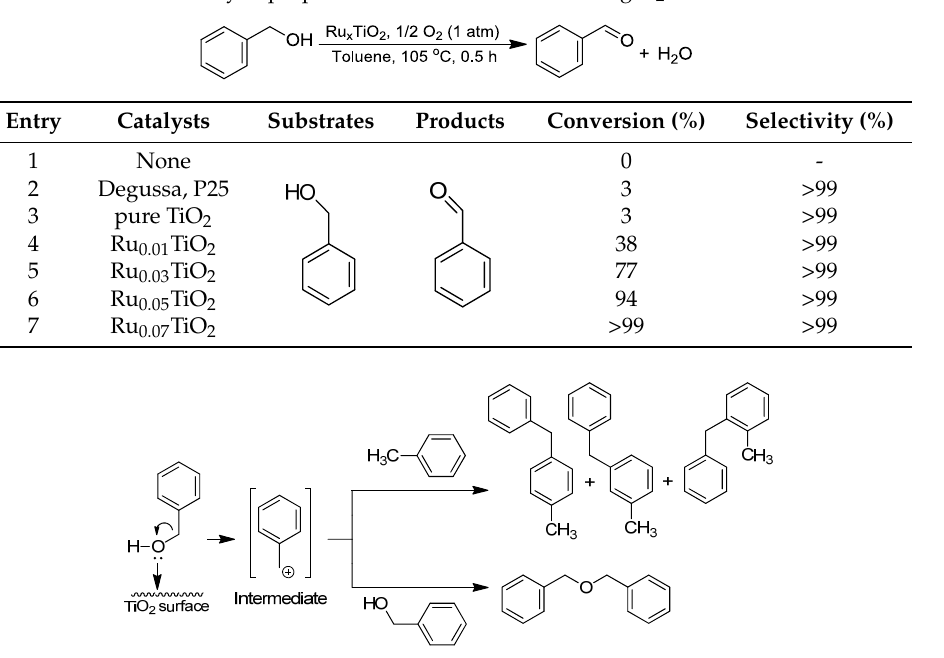
Table 3. Catalytic properties of alcohol oxidation using O 2 as an oxidant.